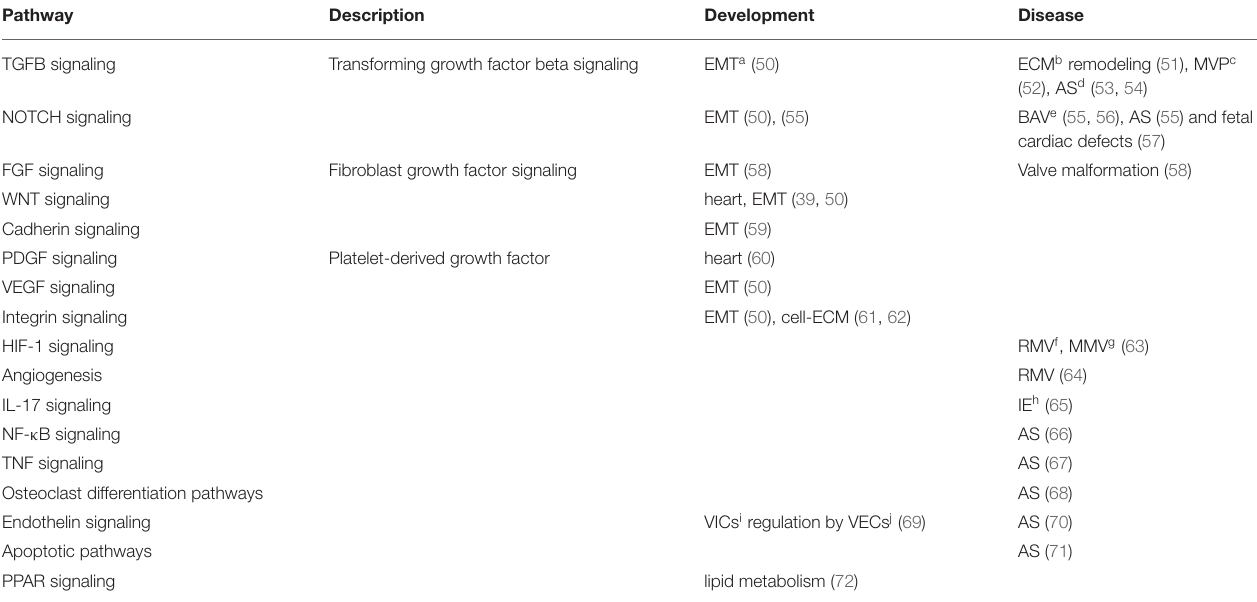
TABLE 4 | Pathways involving the genes associated with the differentially methylated promoters between aortic and mitral valve tissue and their implication in valve development and disease.